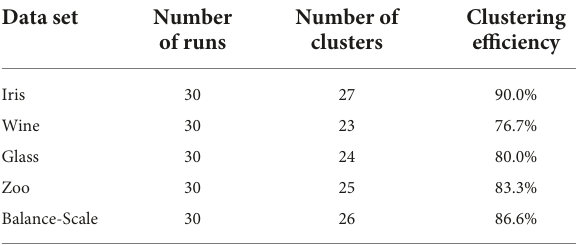
TABLE 2 Clustering effect of the improved clustering analysis algorithm.